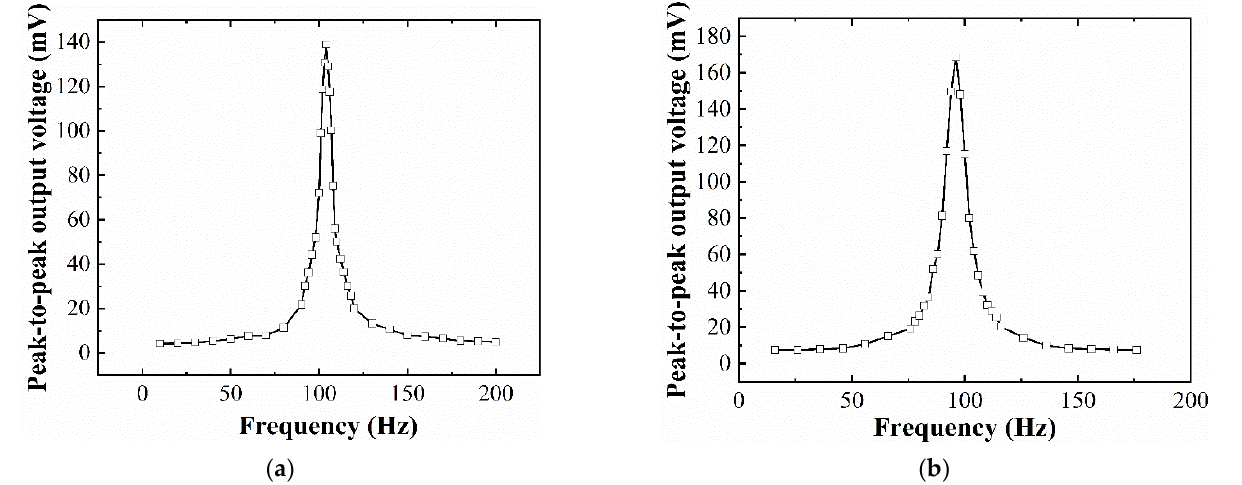
Figure 8. The peak-to-peak open-circuit output voltage of the EVEH as a function of frequency: ( a ) T1 device; ( b ) T2 device.